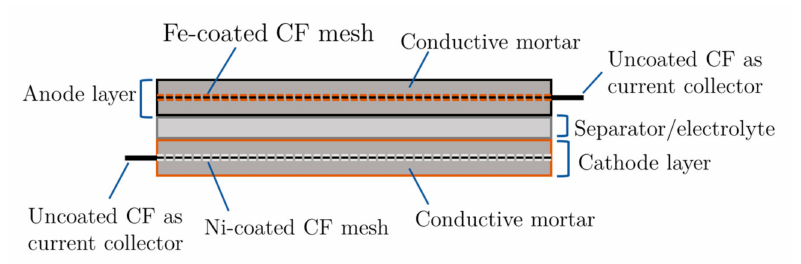
Figure 3. Schematic illustration of the design of the metal-coating